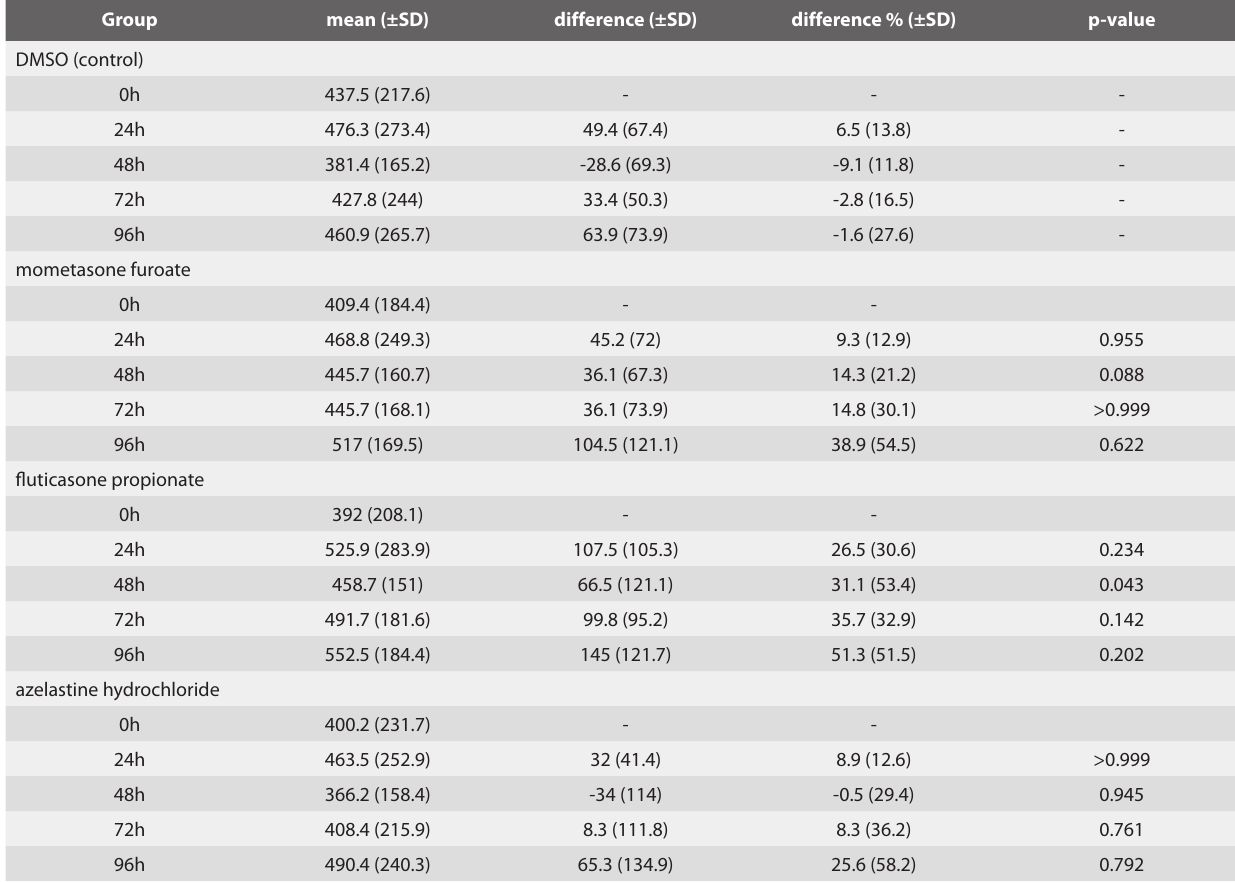
Table 2. Numeric results of the TER regarding the subgroups. Group mean (±SD) p-value DMSO